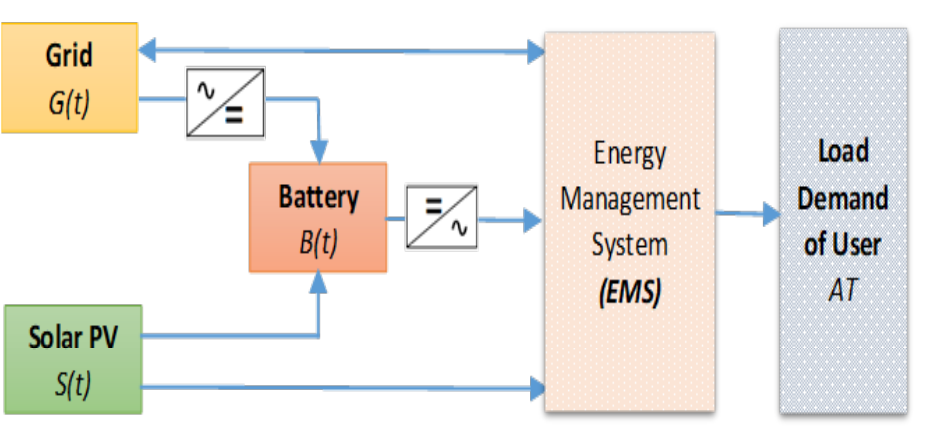
Figure 2. On− grid bidirectional model. Figure 2. On − grid bidirectional